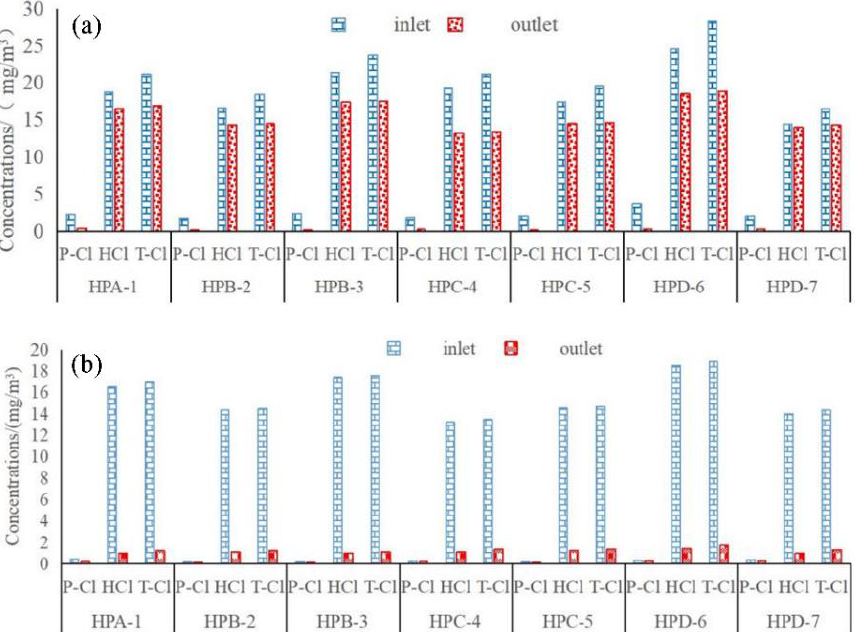
Figure 5. ( a ) Influence of dust collector on distribution of chlorine form in flue gas, ( b ) Influence of desulfurization system on distribution of chlorine form in flue gas. Note: P-Cl: particulate chlorine; HCl: gaseous hydrogen chloride; T-Cl: the sum of particulate Cl, HCl and Cl 2 in flue gas.